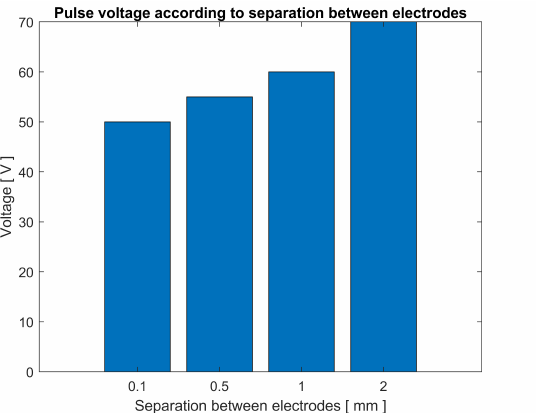
Figure 12. Pulse voltage obtained according to separation between electrodes, with 4 V at the source and pulse frequency of 1